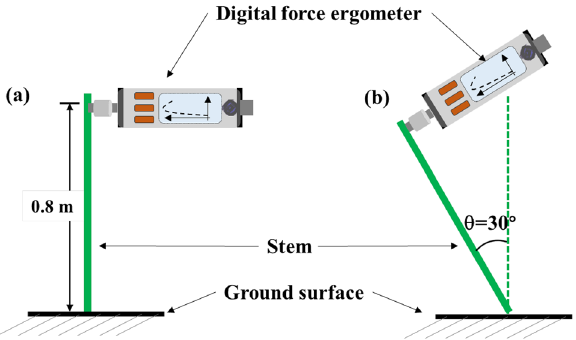
Figure 9. Schematic diagram of the method for measuring the stalk bending strength of maize